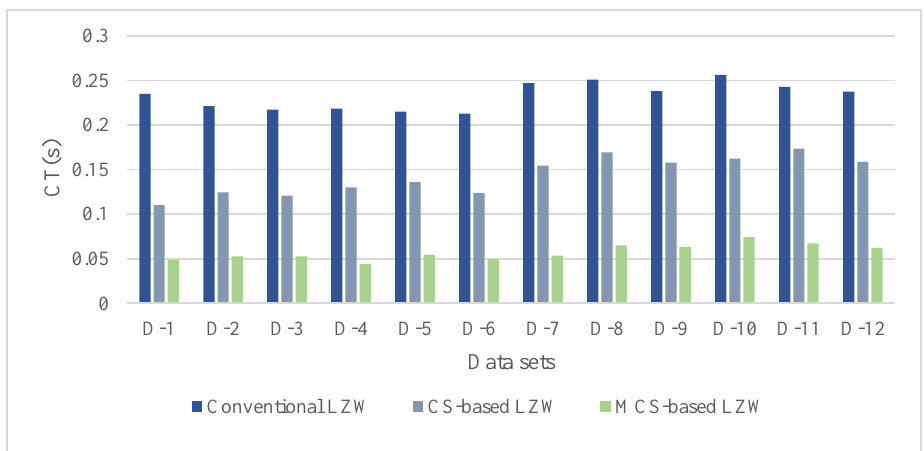
Table 6. SSs of D-CLU algorithm by using LZW compression and without using LZW compression (%). D-1